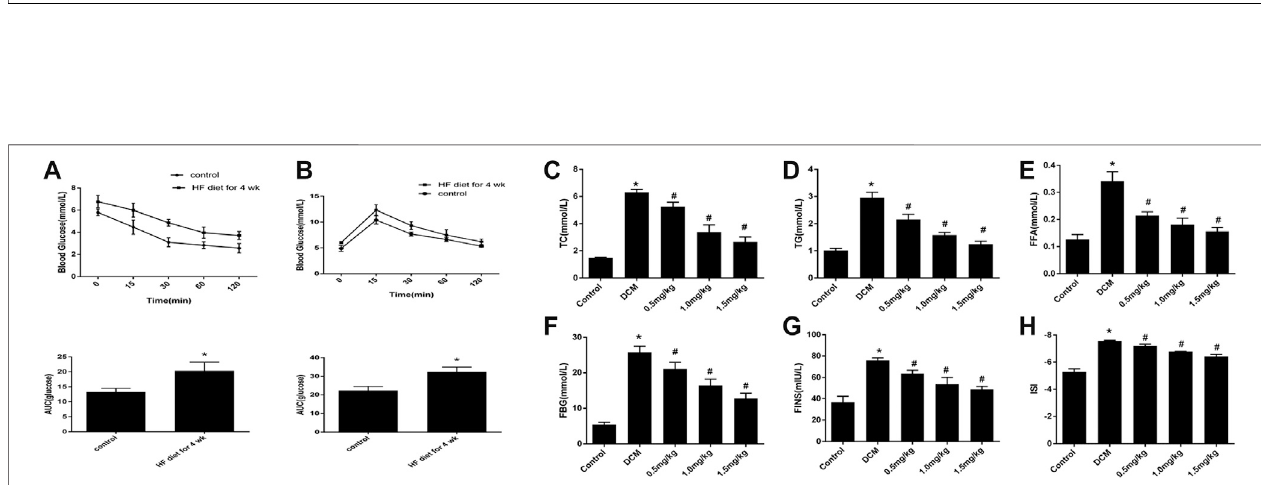
FIGURE 1 | Diagnostic value of SGLT1 for DCM. (A) SGLT1 level in DCM and diabetic patients. * p < 0.05 compared with the control group. (B) ROC curve.